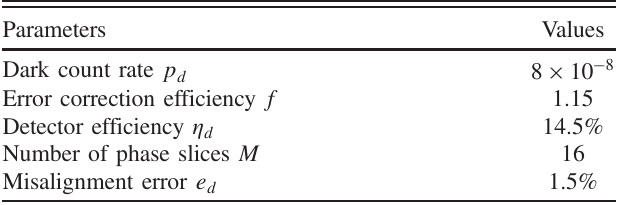
TABLE I. Parameters used for